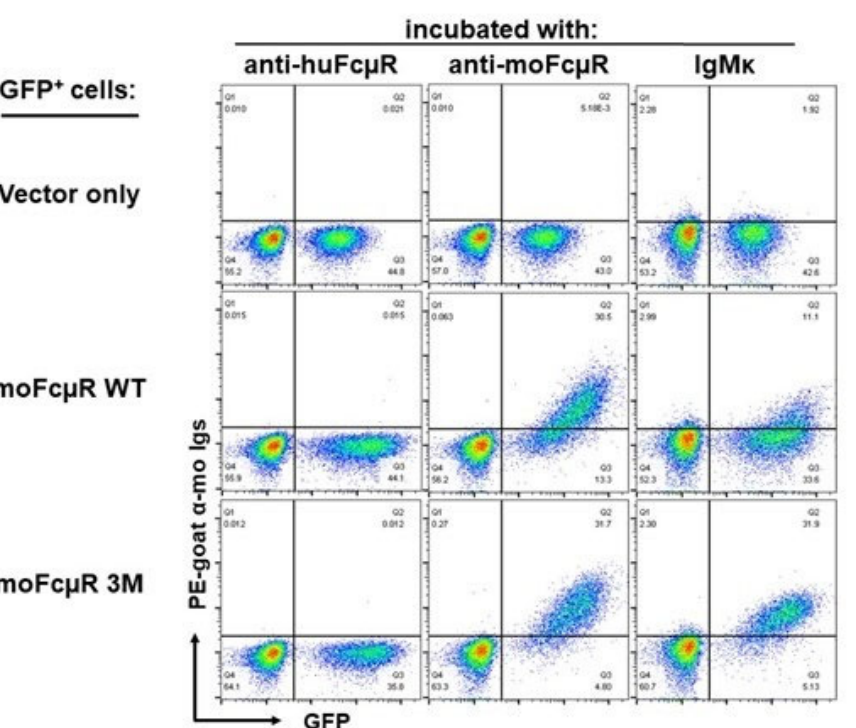
Figure 5. Flow cytometric analysis of FcµR expression and IgM binding by transductants. BW5147 thymoma cell lines were transduced by retroviral bicistronic expression constructs containing only GFP cDNA (vector only; top row) or GFP cDNA and mouse FcµR cDNA of wildtype (WT; middle row) or three site-directed mutations at -66N, TPCLD78-82KQYPR, and K108N (3M; bottom row), before enriching GFP + cells by FACS and establishing stable transductants. An equal mixture of GFP-negative control BW5147 cells and GFP-positive transductants was incubated with IgG1 κ mAbs specific for human Fc µ R (as an isotype-matched control; left column) or mouse Fc µ R (middle column), or with IgM ligand (right column). Bound mAbs or IgM were developed by addition of polyvalent PE-labeled goat anti-mouse Ig antibodies. A representative flow cytometric profile is depicted from five different experiments. Note the significant difference ( p < 0.05) in the mean fluorescence intensities of IgM binding between moFc µ R WT and 3M transductants, as determined by Student’s t